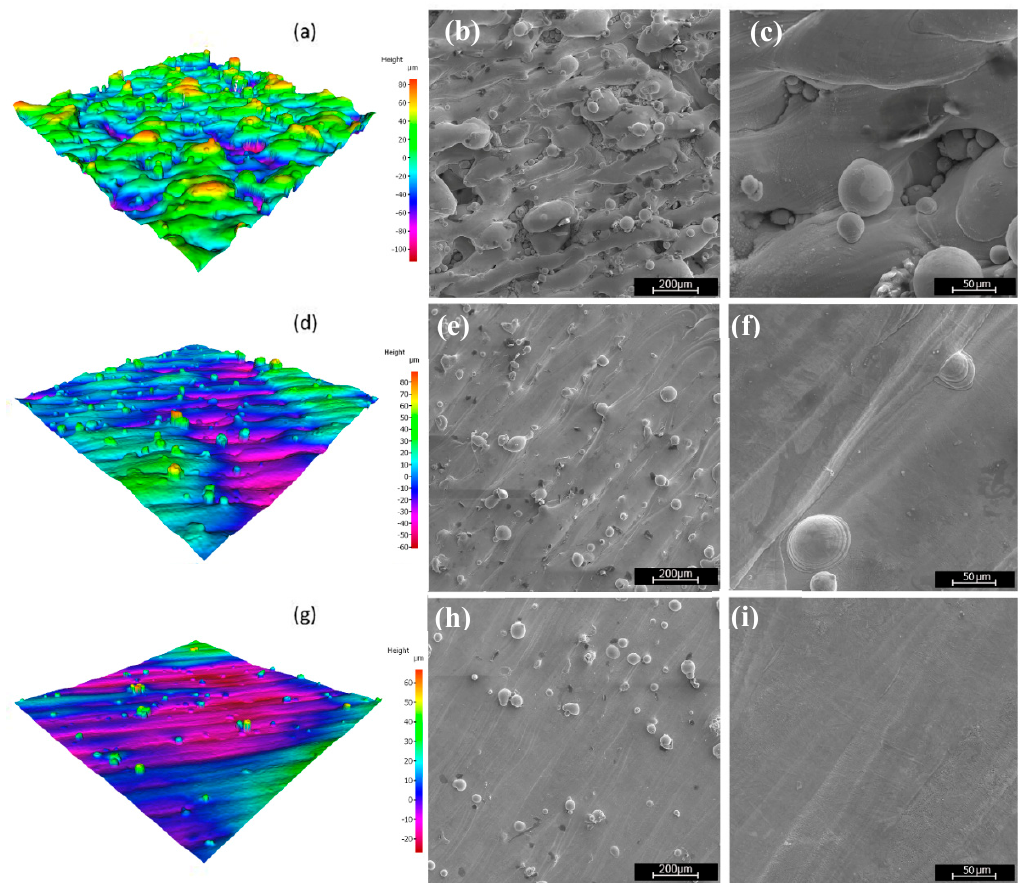
Figure 10. Surface texture scan and SEM micrographs: ( a – c ) Sample A9, ( d – f ) sample B9, and ( g – i ) sample C9.